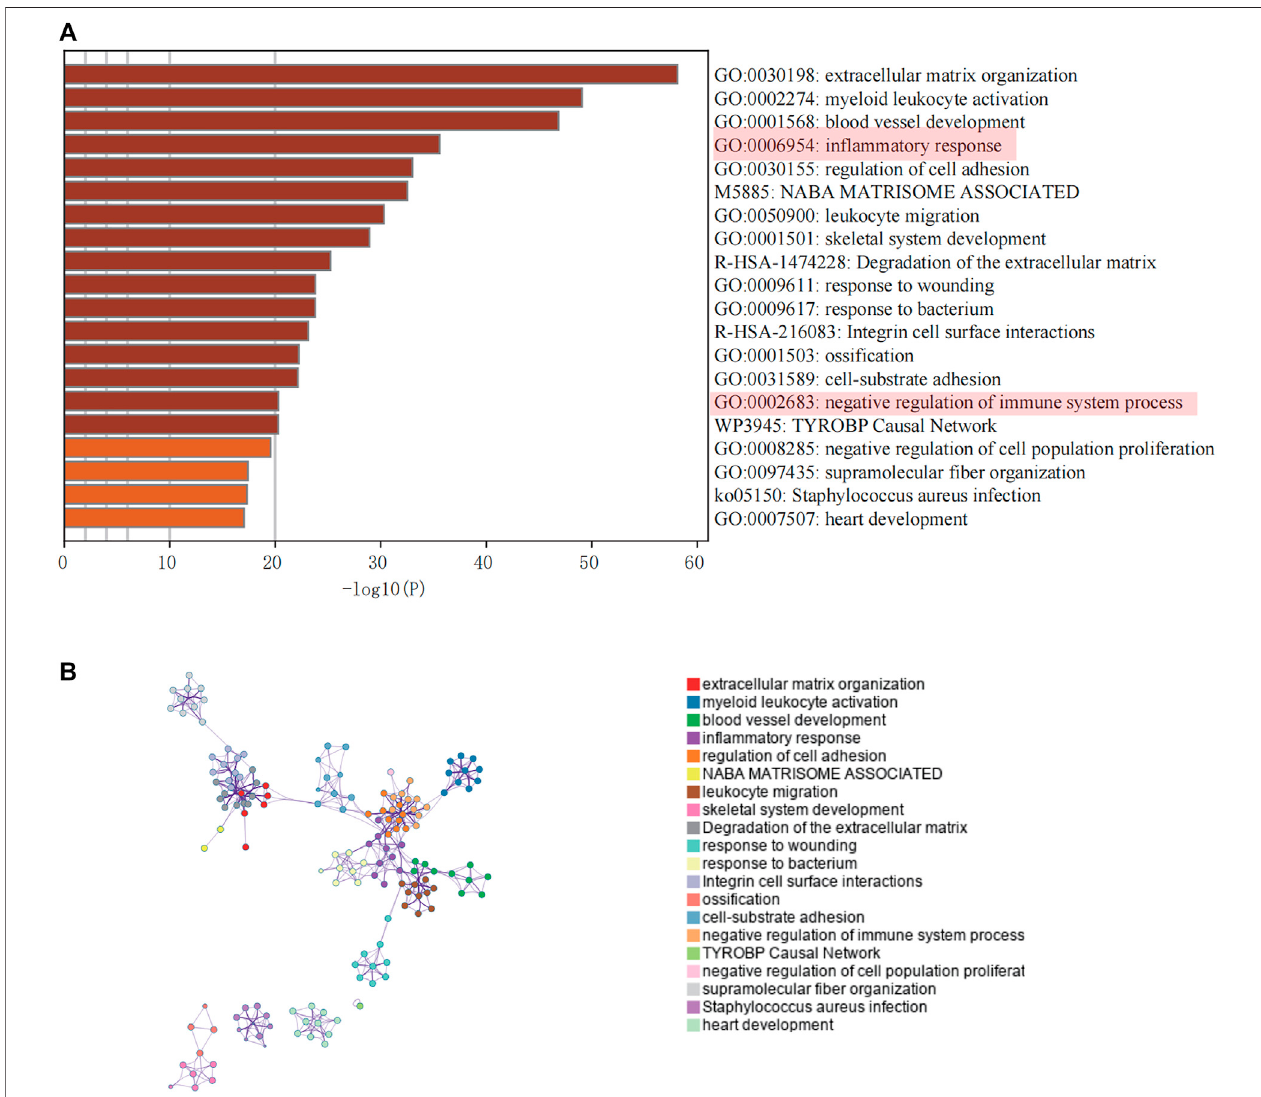
FIGURE 3 | Enrichment analysis of core modules. (A) The top 20 enriched terms are shown in a bar chart. (B) Network diagram showing the association between each enrichment item.